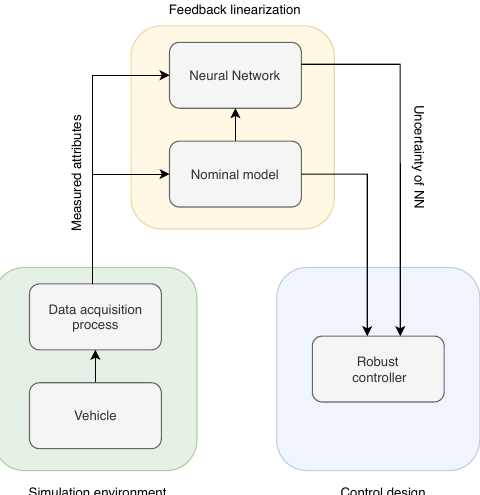
Figure 1. Illustration of the process for control